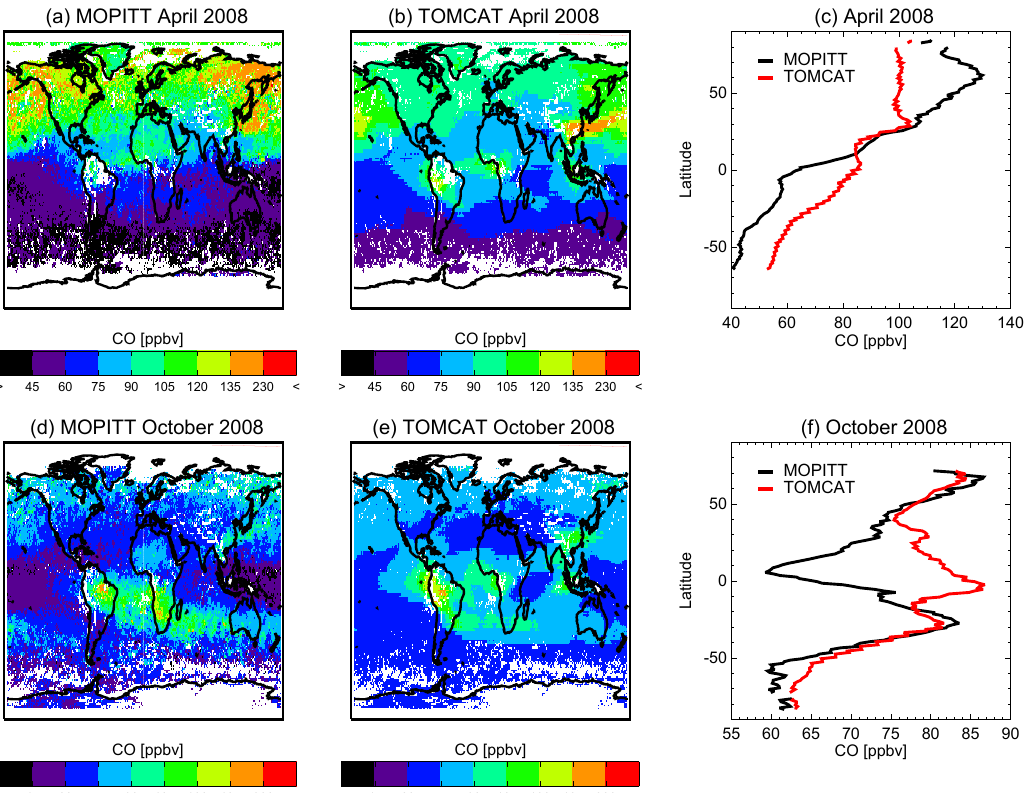
Figure 5. April and October 2008 monthly mean 500hPa CO concentrations (ppbv) observed by MOPITT (a, d) and simulated by TOM- CAT (b, e) . The zonal mean concentrations at 500hPa are also shown ( c, f ; data are only shown when there is > 25% coverage in a given latitude band). MOPITT averaging kernels have been applied to the TOMCAT